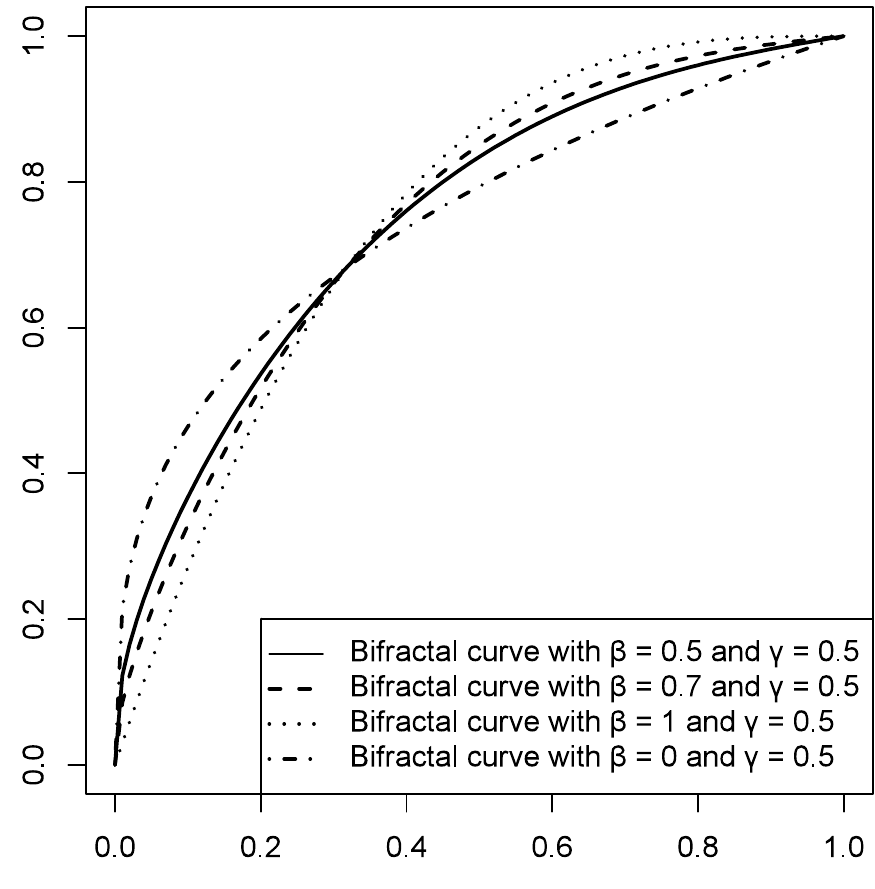
Figure 1. Bifractal curves.